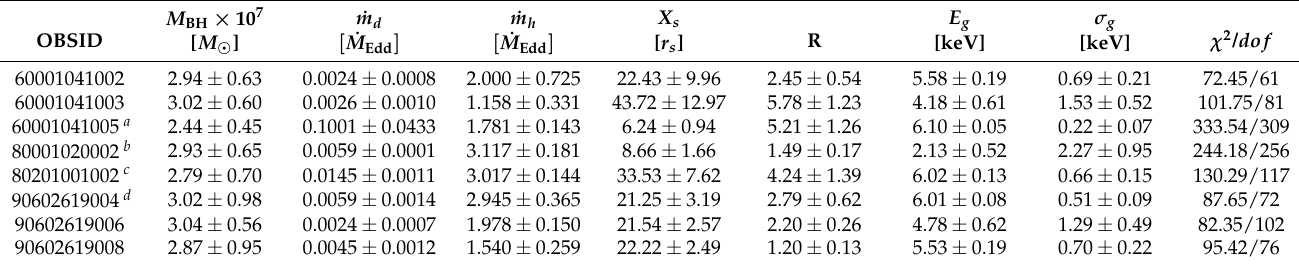
value. a : Gaussian component was added at 5.02 ± 0.18 keV with line width 0.64 ± 0.20 keV. The origin of this line is not clear yet, however, a similar line was observed for Mrk 335 earlier [56]. Table 4. Best-fitting parameters with the TBABS ( TCAF + GAUSS